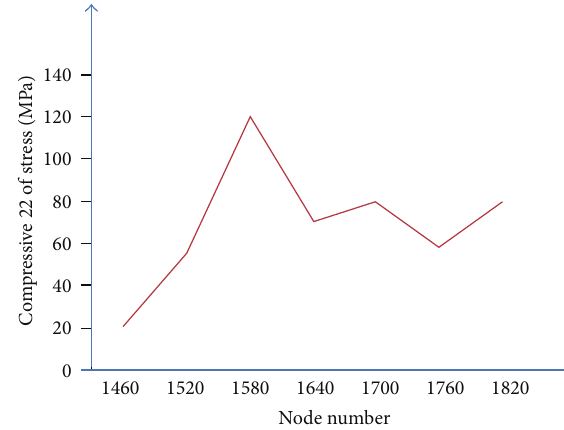
Figure 6: Distribution of vertical stress of interfacial edge node at 28% reduction ratio.